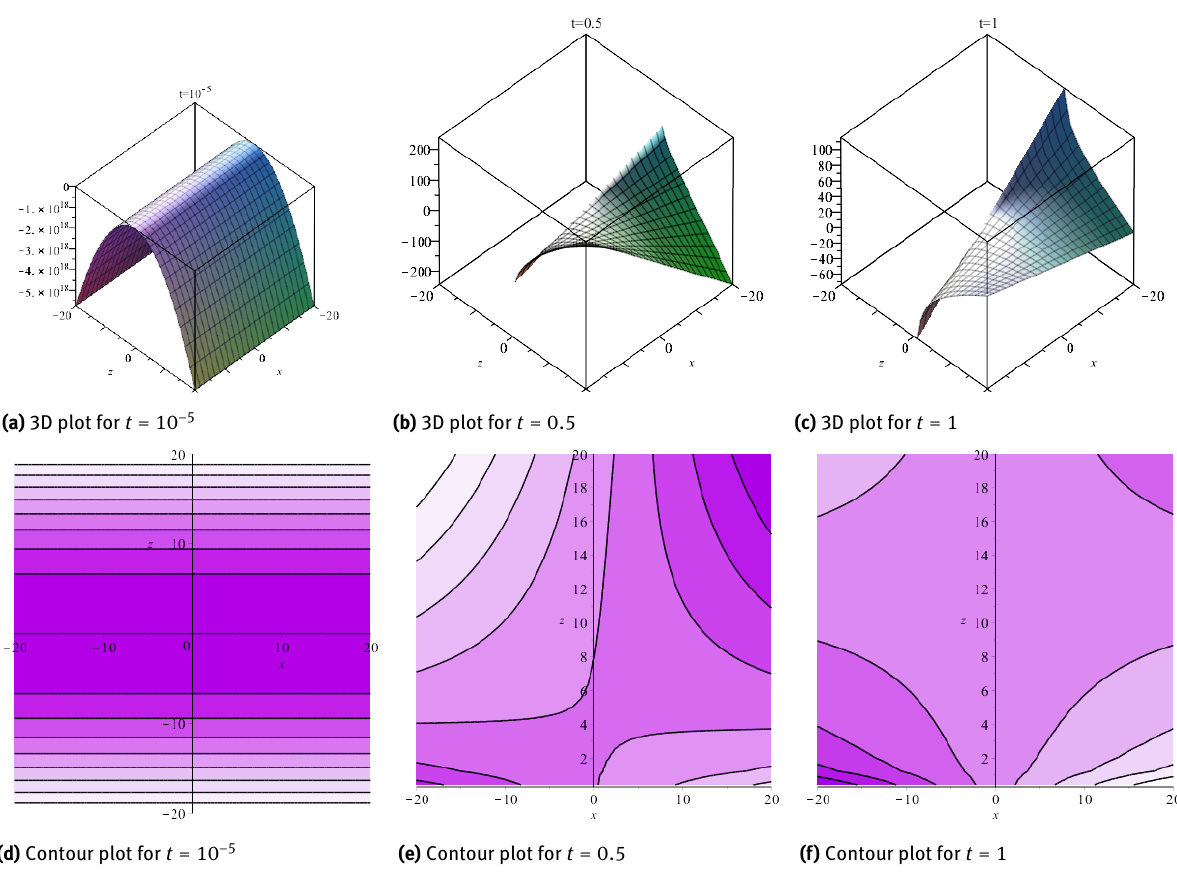
Figure 1: Solution profiles for equation (34) with m 2 = 20 , n 1 = 10 , n 2 = 20 and y = 5